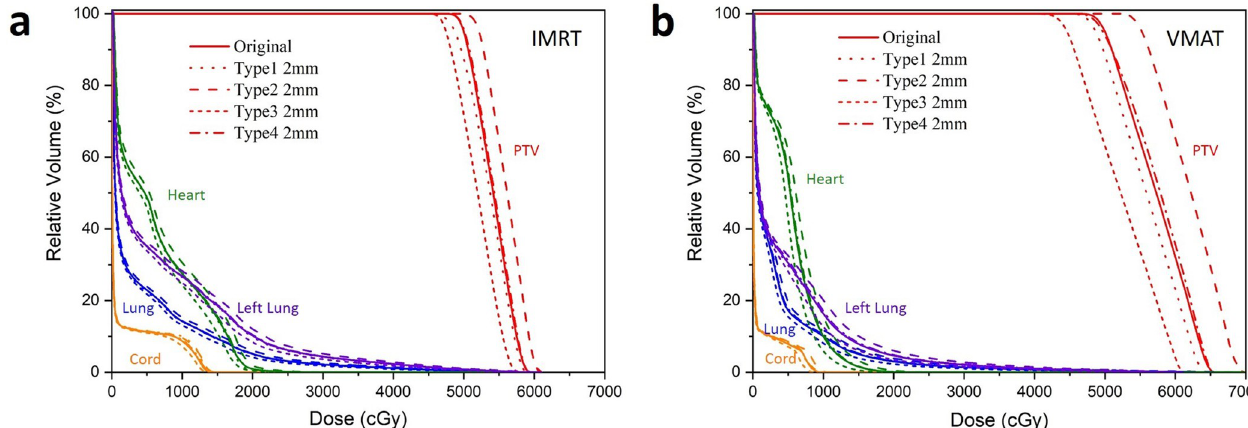
Fig 2. A sample dose–volume histogram of patient 5. This figure shows A sample DVH of the PTV, left lung, lung, heart, and spinal cord for the baseline plan and different simulation plans with an MLC position error of 2 mm for each case. 2(a) IMRT plans; 2(b) VMAT plans. https://doi.org/10.1371/journal.pone.0278422.g002 Dosimetric parameters comparison of PTV between IMRT and VMAT The results of the percentage changes for CI, GI, and D are shown in Fig 3 for all four types 2cm of MLC position errors. Fig 3(A) shows that the CI decreased with increasing MLC error. The changes in the closing error were the largest, followed by the opening error, and the random error was minimal. In addition, IMRT plans are less sensitive than VMAT plans to dose devia- tions caused by the same type of MLC error.